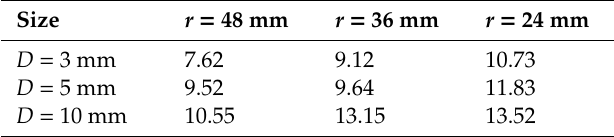
Table 1. Reconstruction error when using single frequency